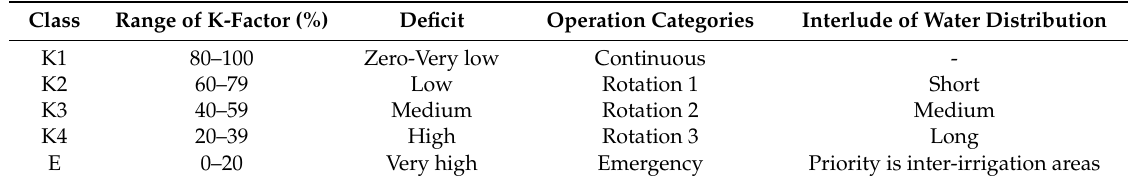
Table 1. K-factor standard for irrigation